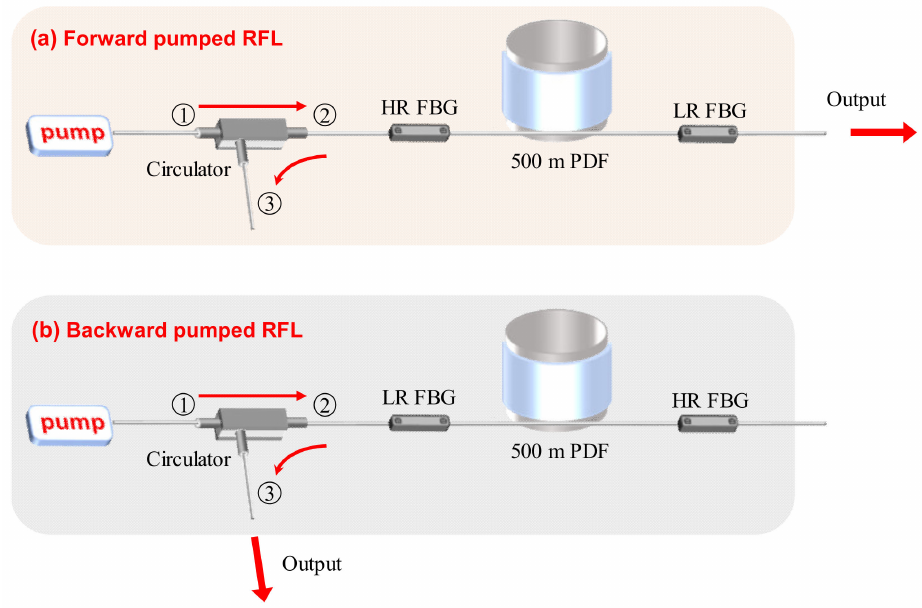
Figure 3. The experimental setups of ( a ) forward-pumped low-quantum defect Raman fiber laser and ( b ) backward-pumped low-quantum defect Raman fiber laser. HR, high-reflective; LR, low-reflective; FBG, fiber Bragg